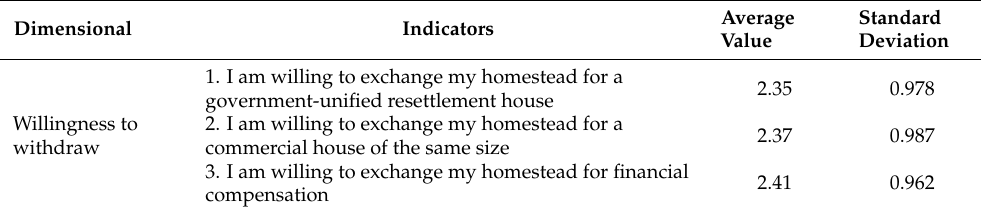
Table 4. Homestead withdrawal intention evaluation